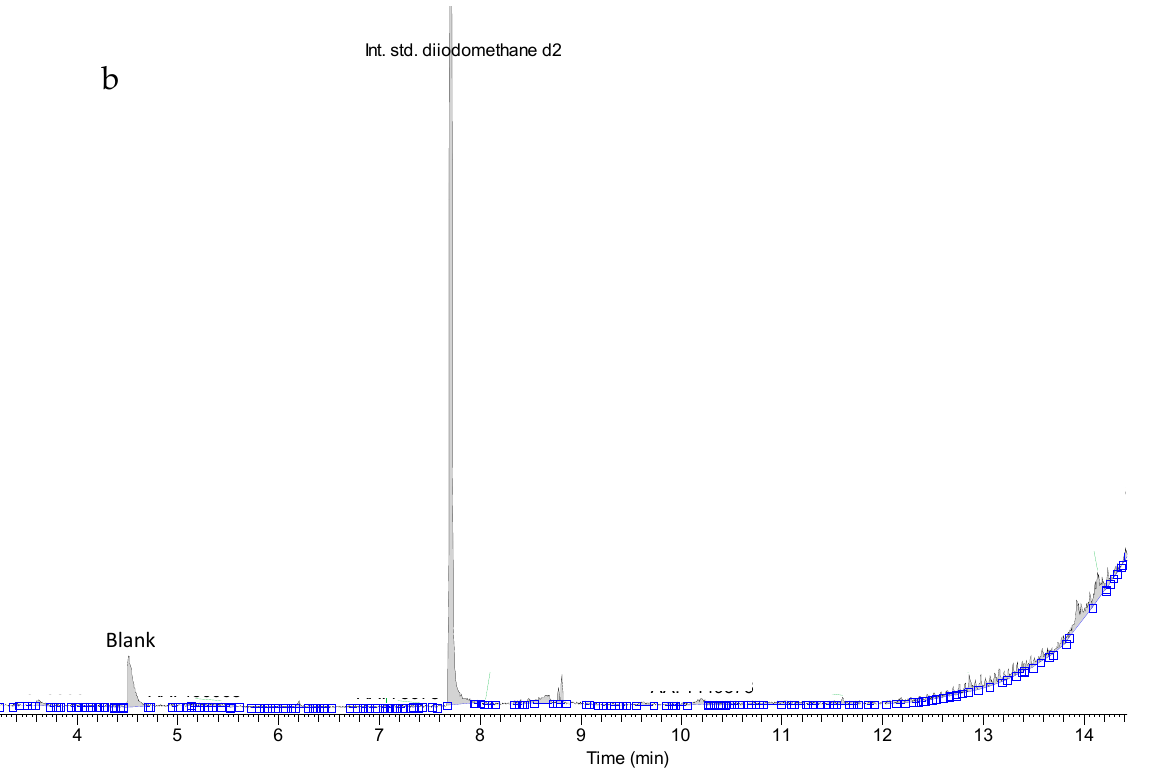
Figure 1. ( a ) Metabolic profile of Asparagopsis taxiformis showing halomethanes, bromoform, dibromomethane, dichlorobromomethane and diiodomethane d2, used as an internal standard, and other tentatively identified volatile halocarbons. ( b ) Representative metabolic profile of other seaweeds in this study showing only diiodomethane d2, used as an internal standard.